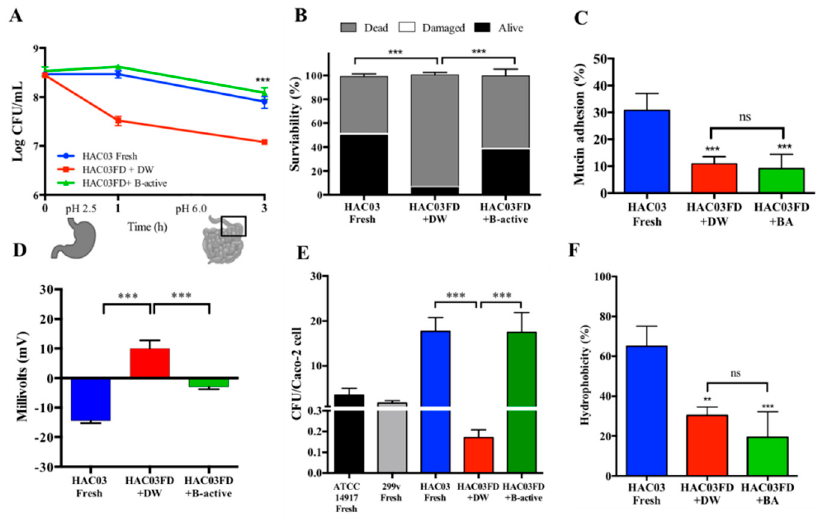
Figure 2. Comparison of freeze-dried Lp. plantarum HAC03 probiotic properties under different rehydration conditions. ( A ) Viability of Lp. plantarum HAC03 freeze-dried cells rehydrated in the presence of B-active (green line), without B-active (red line), and overnight cultured cells (blue line) after simulation of the GIT passage by plate counting. ( B ) Real-time Lp. plantarum HAC03 viability determined by flow cytometry and the exclusion method with propidium iodide. ( C ) Lp. plantarum HAC03 mucin adhesion, ( D ) zeta potential, ( E ) adhesion to Caco-2 cell line, and ( F ) hydrophobicity after rehydration with B-active formulation. Lp. plantarum ATCC14917 and Lp. plantarum 299v fresh overnight cultured cells were used as a reference and probiotic control, respectively. The experiments were carried out after rehydration and ten-fold dilution of the samples. Statistical differences were compared to HAC03 freeze-dried cells rehydrated with distilled water by one-way ANOVA and Dunnett’s multiple comparisons test, where ** p < 0.01, and *** p < 0.005.